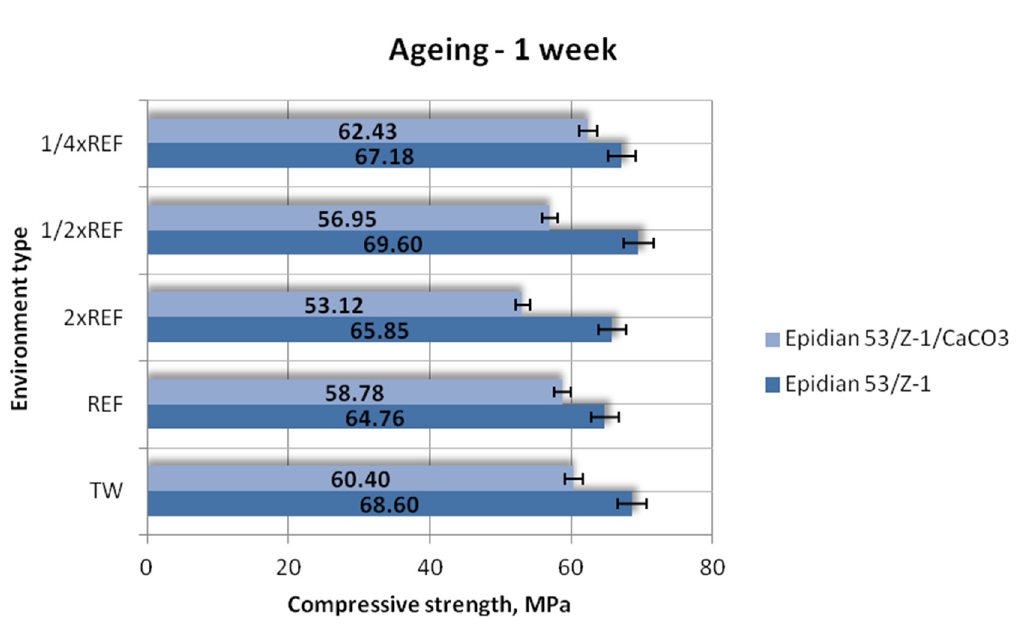
Figure 3. Compressive strength of the unmodified (Epidian 53 / Z-1) and modified (Epidian 53 / Z-1 / CaCO 3 ) epoxy adhesive compounds, aged for 1 week.